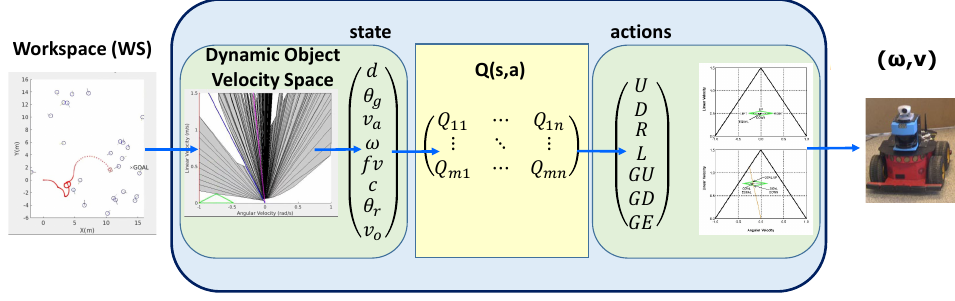
Figure 2. General architecture of the navigation system. WS represents the workspace; Q ( s , a ) is the Q − table, and ( ω , v ) are the velocities